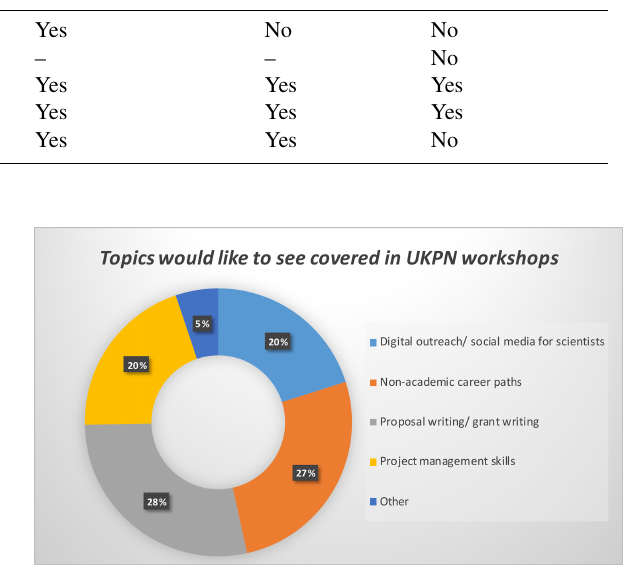
Figure 3. Example survey results showing how an ECN helped the career of ECS (free answers were possible).